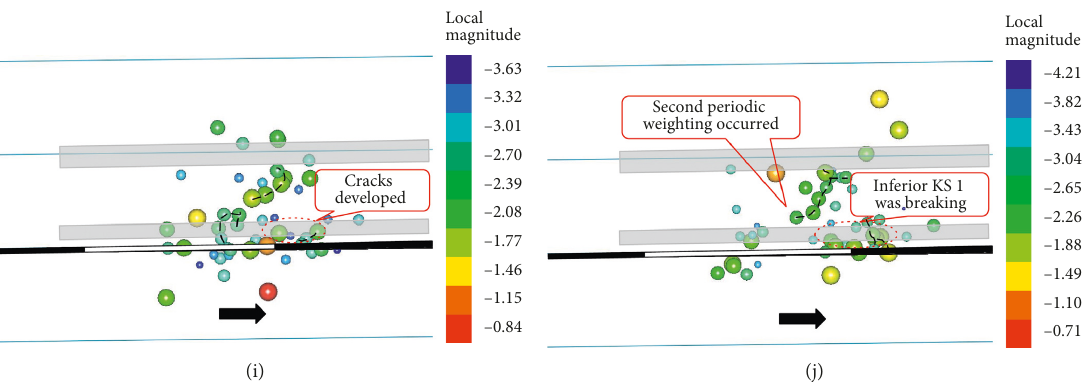
Figure 5: MS events evolution of the inferior KS breakage: (a) Aug 31, (b) Sep 1, (c) Sep 3, (d) Sep 4, (e) Sep 5, (f) Sep 6, (g) Sep 7, (h) Sep 8, (i) Sep 9, and (j) Sep